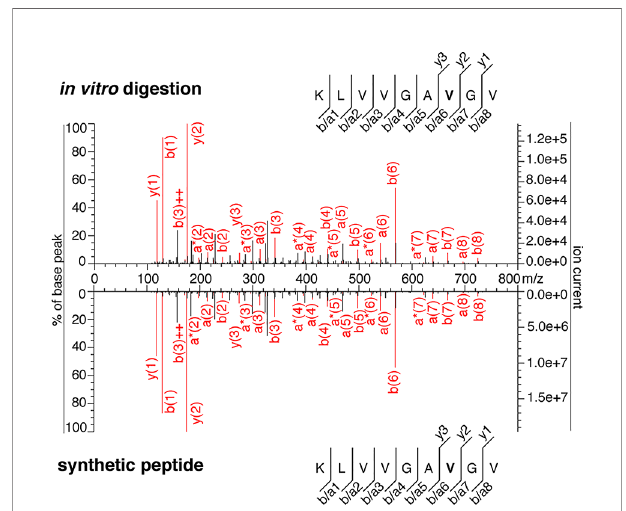
FIGURE 5 | MS2 spectra of the KRAS 5-6/8-14 G12V cis -spliced peptide. MS2 spectrum of the peptide KRAS 5-6/8-14 G12V [KL][VVGA V GV] identi fi ed in an in vitro 20 h digestion of the synthetic polypeptide KRAS 2-35 G12V with proteasomes and of the cognate synthetic peptide. The in vitro 20h digestion was performed months earlier than the assays shown in Figures 3 – 5 of (11). This in vitro 20 h digestion and the cognate synthetic peptide were measured through the Fusion Lumos Orbitrap months earlier than the assays shown in Figures 4 and 5 of (11). The peptide sequence is shown with the corresponding b-, a- and y-ions identi fi ed. The G12V mutation is depicted in bold. In the spectra, assigned peaks for b-, a- and y-ions are reported in red. Ion neutral loss of ammonia is symbolized by * and double charges by